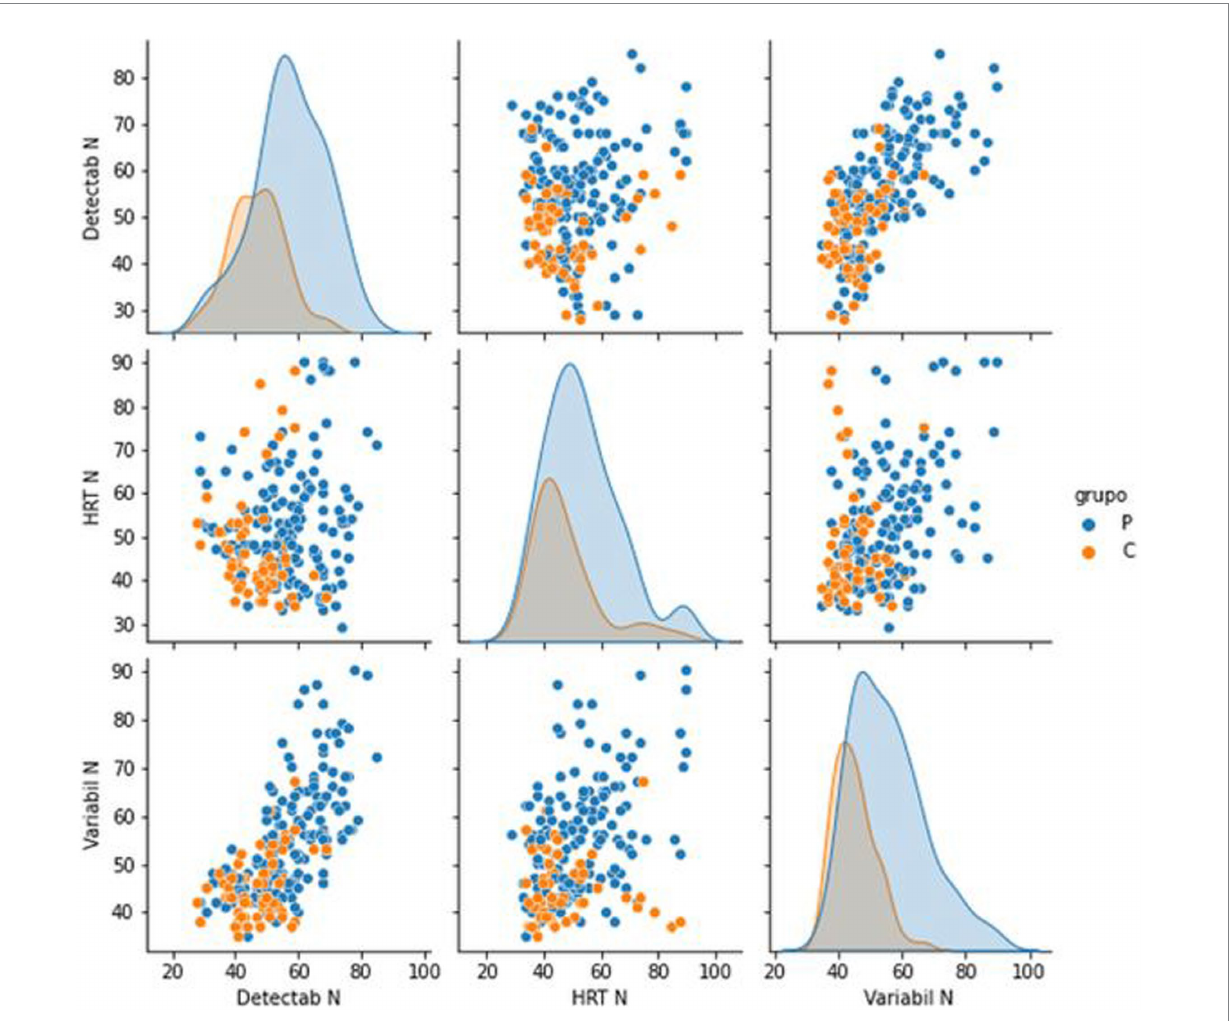
FIGURE 5 Pair plot analysis of the most significant features to discriminate between groups. Histograms as a function of the group and scatter plots of the combinations between the three chosen